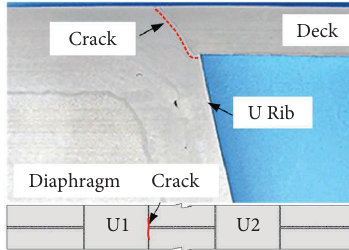
Figure 13: Fatigue crack in rib-to-deck and diaphragm joint [12].